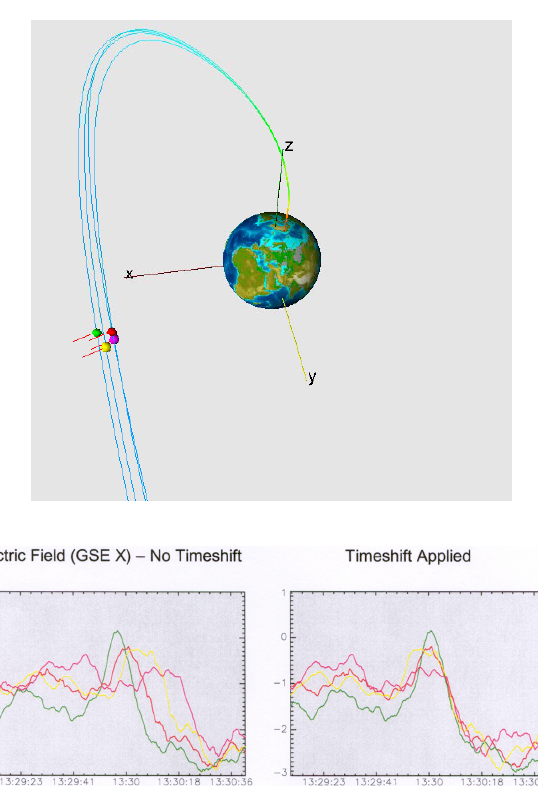
Fig. 17. Top panel: plot of the Cluster satellite constellation and the bundle of field lines that they are observing, as modelled by the Cluster orbit visualisation tool; left bottom panel: high res- olution EFW data between 13:29:20 and 13:30:30 UT showing a transient in the total electric field measurements on all four Cluster spacecraft, and right bottom panel: the same EFW data but time- shifted according to a feature passing the satellites with a velocity of v x = − 84, v y = − 6 and v z = − 38km/sec. The OVT colour- coding of the satellites and the data is red, green, yellow, and mag- neta for spacecraft1, 2, 3 and 4,